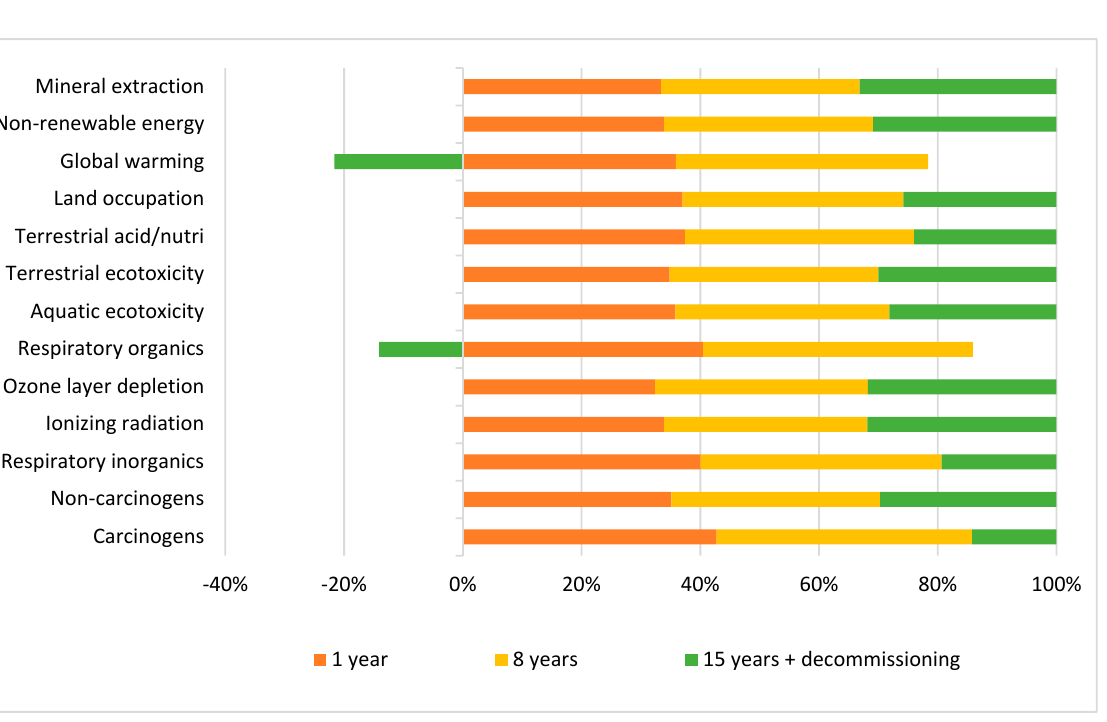
Figure 4. Life ‐ cycle assessment of a 500 ‐ kW heat output Stirling cycle ‐ based HP. Figure 4. Life-cycle assessment of a 500-kW heat output Stirling cycle-based HP. When decommissioning is included in the assessment, the impact category global warming and respiratory organic e ff ects show negative values, which means a positive e ff ect on the environment. This e ff ect stems from the 90% recycling of the engine’s